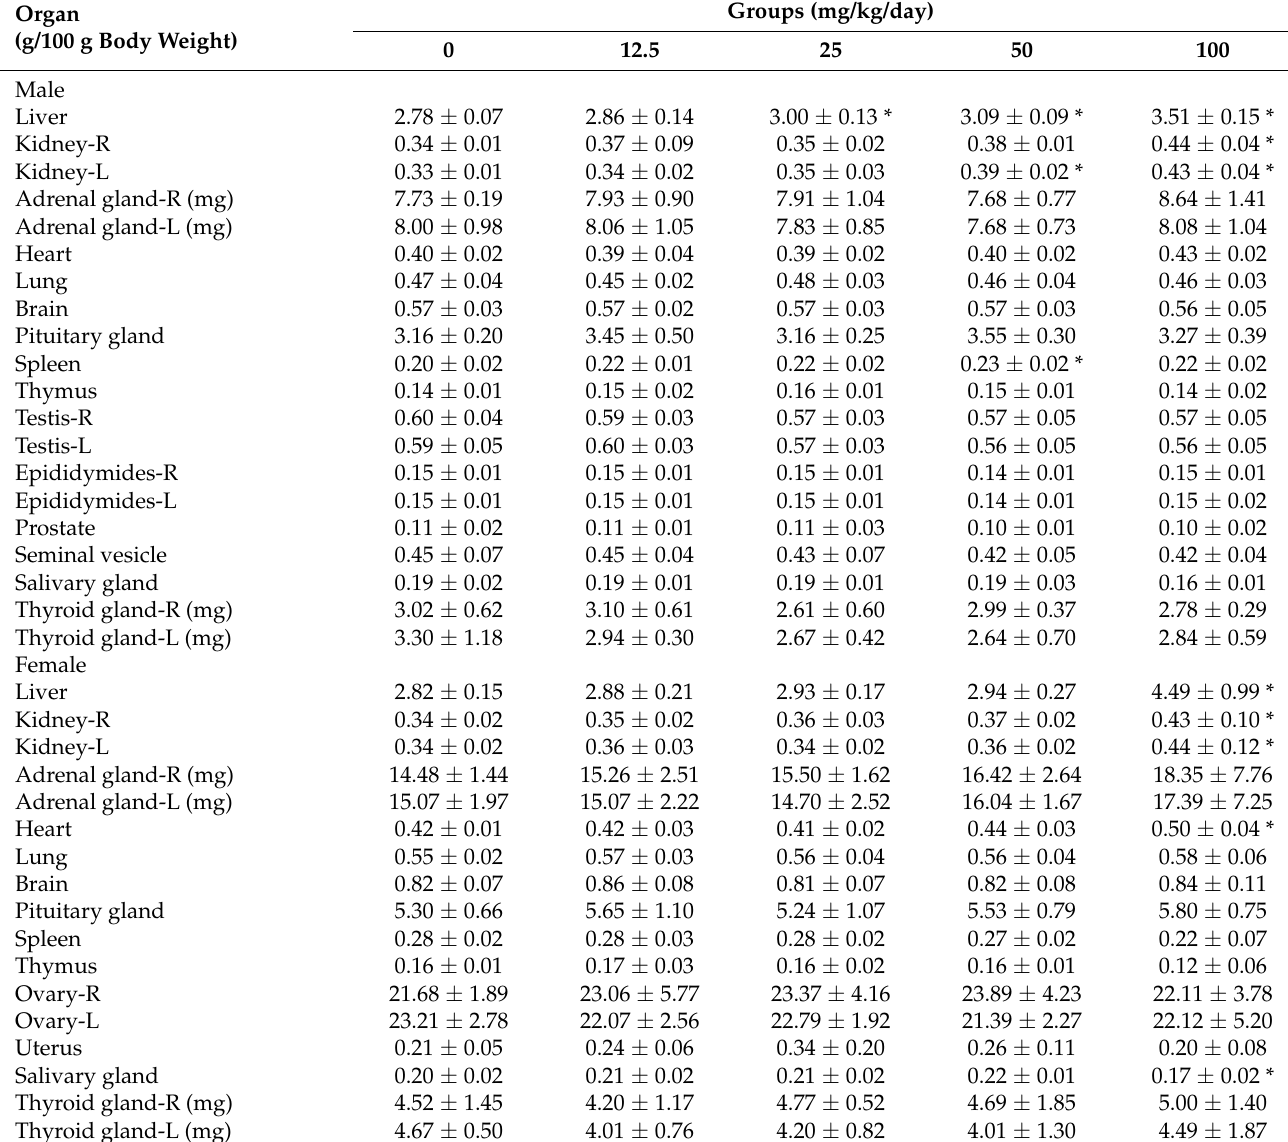
Table 5. Relative organ weights after the 28-day repeated oral toxicity